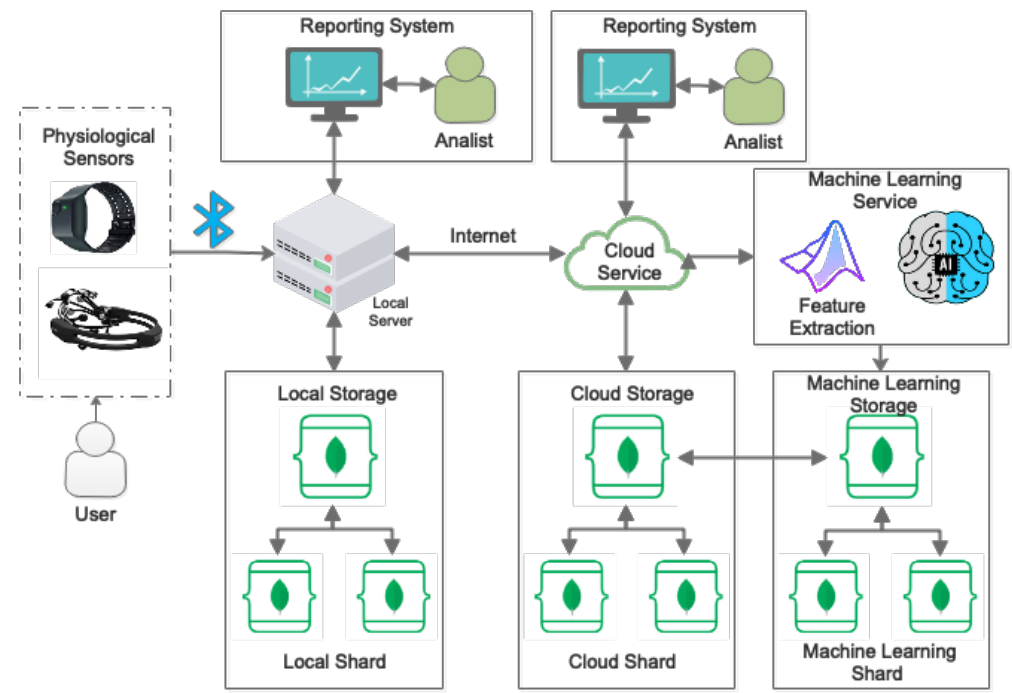
Figure 2. Distributed architecture scheme for the acquisition and processing of physiological